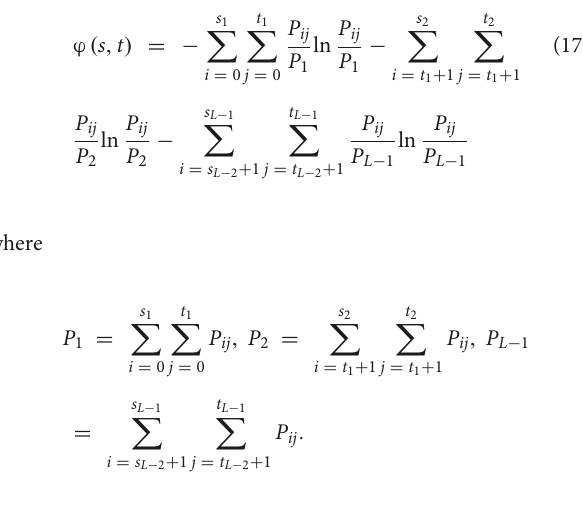
deviation, and L and q ,